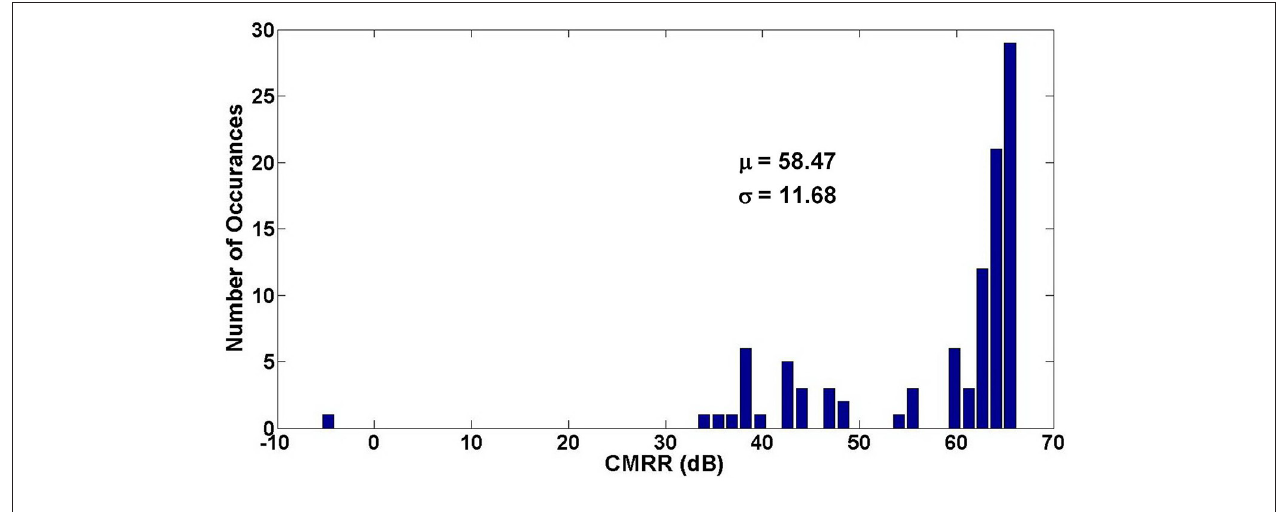
FIGURE 15 | Monte Carlo analysis of CMRR of the neural amplifier.